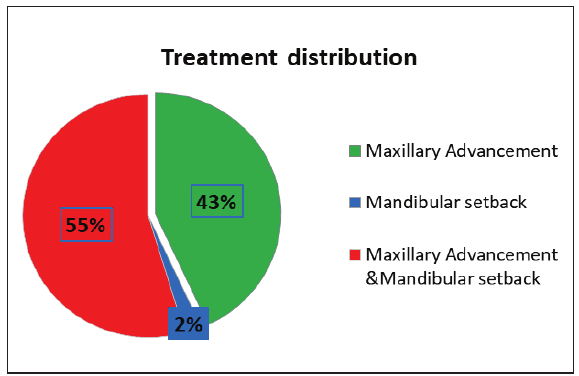
Figure 1. Distribution skeletal Class III surgical procedures between 1985 and 2016.